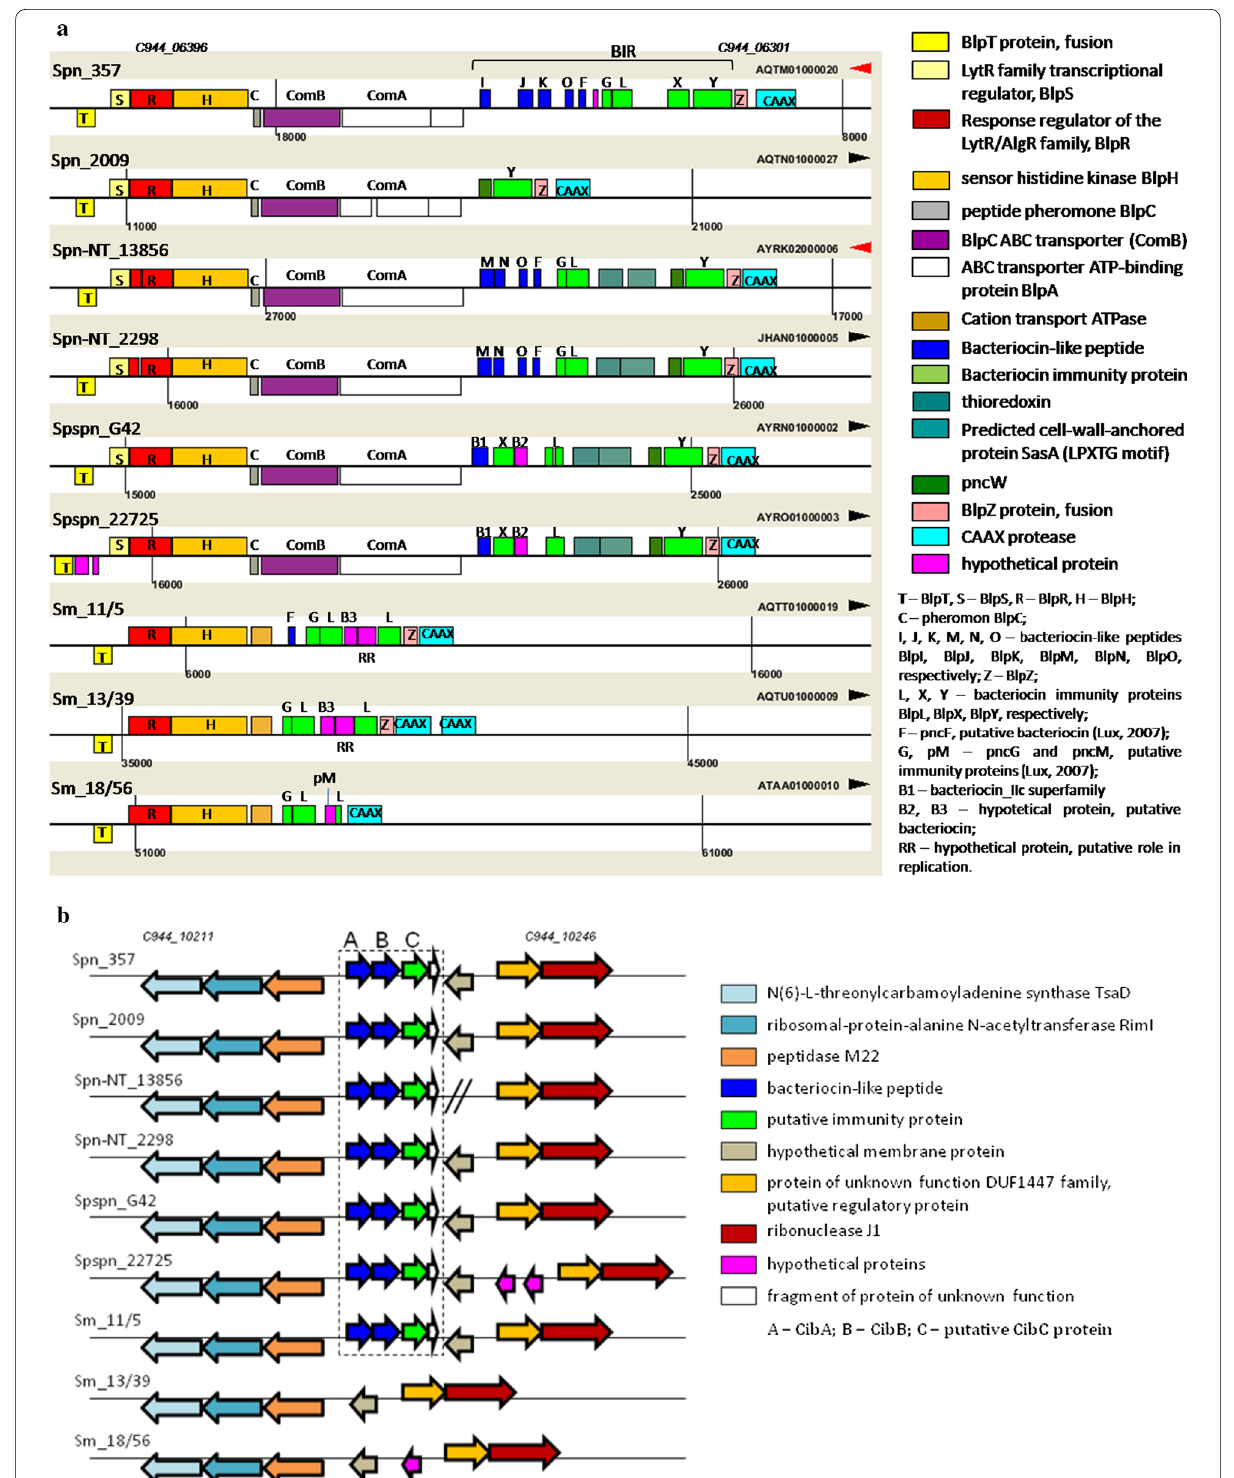
Fig. 1 Reconstruction of blp ( a ) and cibAB ( b ) gene cluster structures according to genome analysis of nine VGS strains under study. The upper pic- ture is prepared using of JContextExplorer v. 3.0 program (Seitzer et al. 2013). Homologous genes in compared samples are indicated by the same color (excluding the bacteriocin- and immune protein coding genes in the upper picture). Double slash in the lower picture indicates the gap in the nucleotide sequence of Spn-NT_13856 (a point of joining of two contigs). Here and further: NCBI identifiers of the first and last genes of genome fragments presented are given for